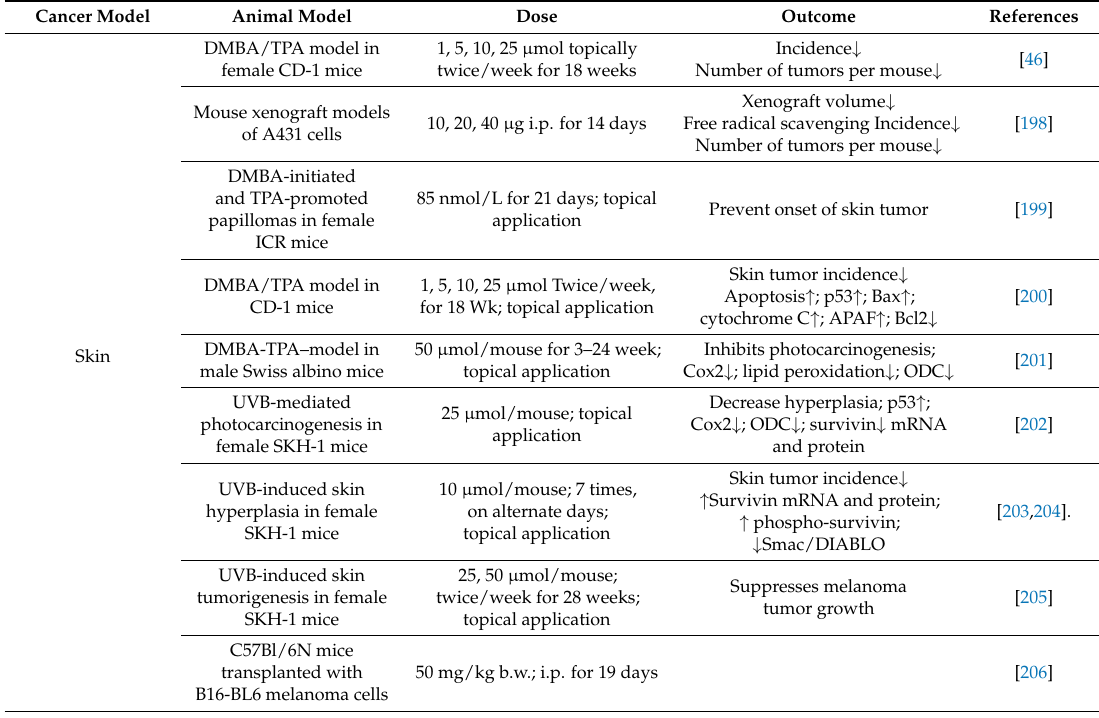
Table 1. In vivo anti-cancer effects of